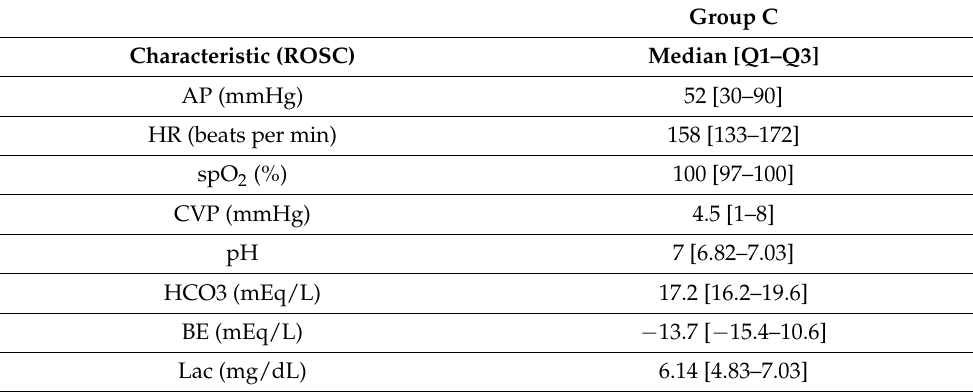
Table 4. Animal characteristics at ROSC. Venous and arterial blood samples and hemodynamic parameters. AP = Arterial Pressure, HR = Heart Rate, spO 2 = Oxygen saturation, CVP = Central venous pressure, pH = potential of hydrogen, HCO 3 = Bicarbonate, BE = Base Excess, Lac = Lactate. Group C